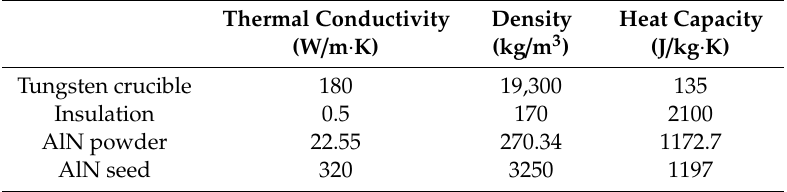
Table 1. Thermophysical properties of materials in the growth chamber.